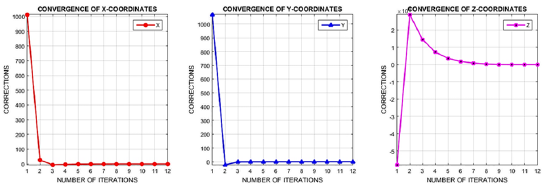
Figure 13. Convergence of pose corrections to zero values.